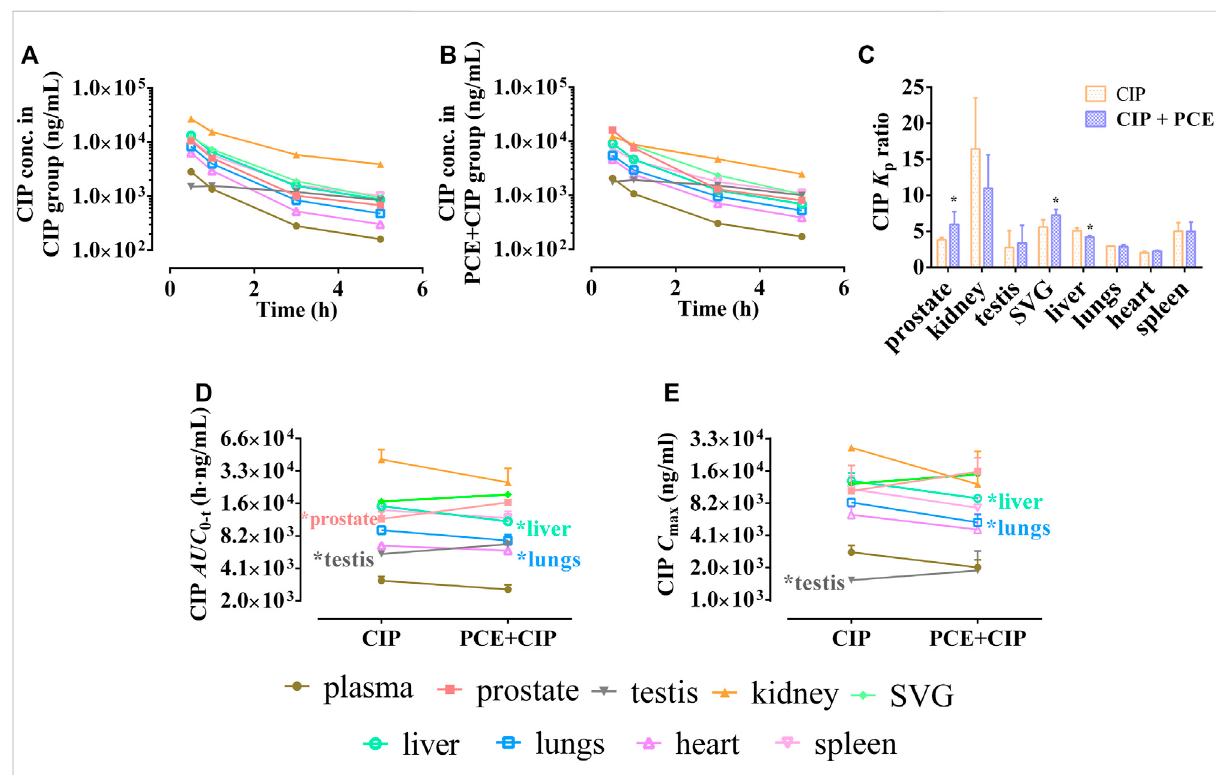
FIGURE 6 Tissue distribution pro fi les of cipro fl oxacin (CIP) after intravenous administration of CIP in the absence (A) and presence (B) of PCE to rats, as well as the tissue to plasma distribution coef fi cients [ K p , (C) ] and the distribution parameters AUC 0-t (D) and C max (E) of CIP (mean ± SD, n =